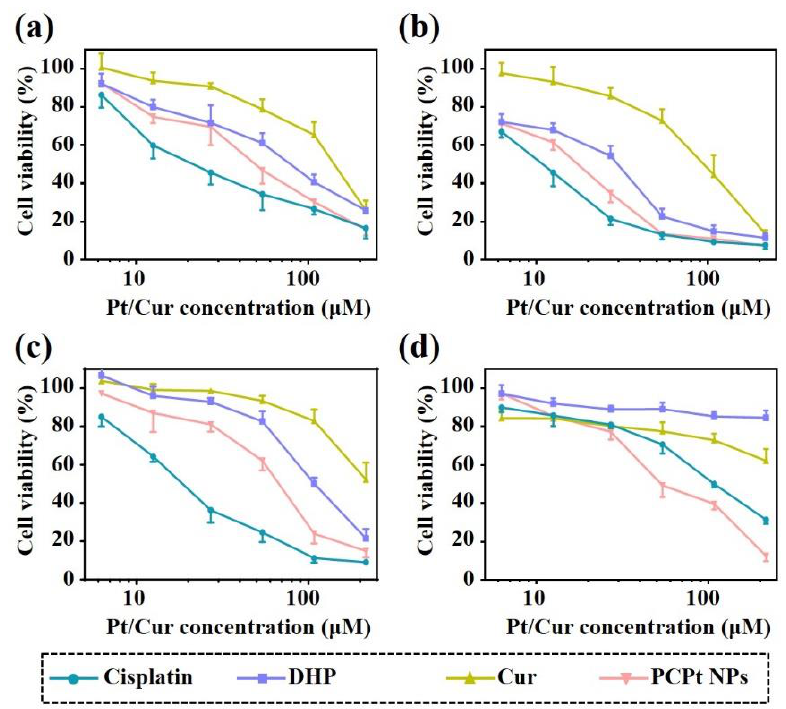
Figure 5. ( a ) The viability of HeLa cells incubated with various drugs and PCPt NPs at different concentrations for 48 h. ( b ) The viability of HeLa cells incubated with various drugs and PCPt NPs at different concentrations for 72 h. ( c ) The viability of A549 incubated with various drugs and PCPt NPs at different concentrations for 48 h. ( d ) The viability of A549/DDP cells incubated with various drugs and PCPt NPs at different concentrations for 48 h. The error bars are based on the standard deviations of four parallel samples.